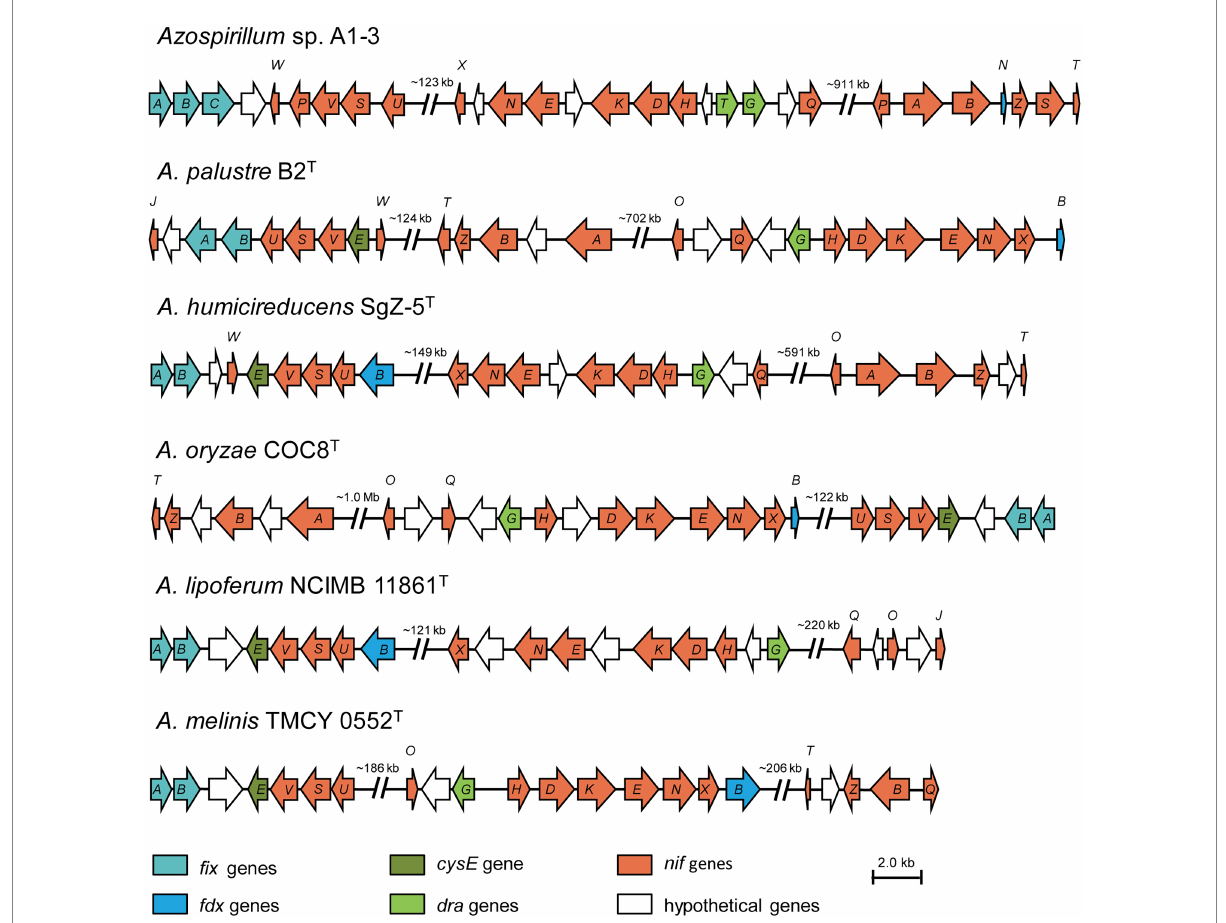
FIGURE 4 Comparison of the nif gene clusters of Azospirillum sp. A1-3 with Azospirillum palustre B2 T , Azospirillum humicireducens SgZ-5 T , Azospirillum oryzae COC8 T , Azospirillum lipoferum NCIMB 11861 T , and Azospirillum melinis T MCY 0552 T . The arrow indicates genes transcriptional direction. The hypothetical proteins were colored in